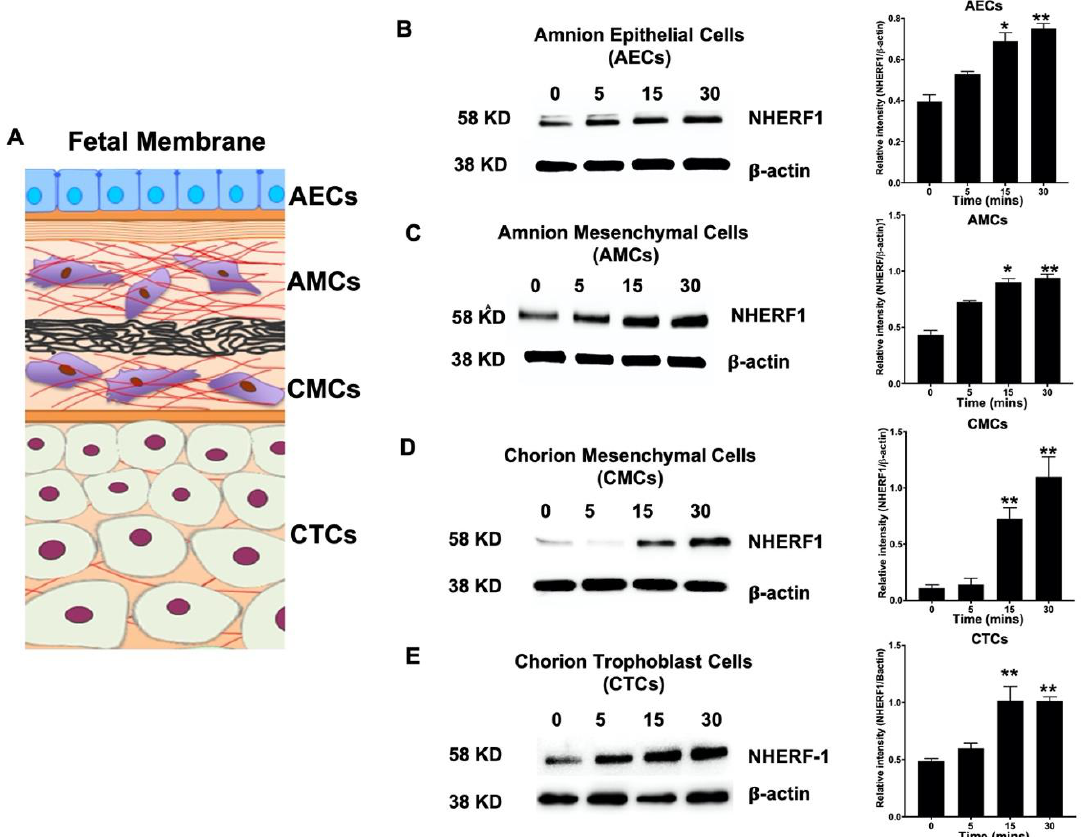
Figure 4. Expression levels of NHERF1 in human fetal membrane primary cells induced by LPS. ( A ) Representation of di ff erent layers of human fetal membrane. WB analysis of ( B ) amnion epithelial cells (AECs), ( C ) amnion mesenchymal cells (AMCs), ( D ) chorion mesenchymal cells (CMCs), and ( E ) chorion trophoblast cells (CTCs) to determine the levels of NHERF1 in response to LPS at di ff erent timepoints. The relative levels of NHERF1 significantly increased in a time-dependent manner with LPS treatment compared to the control in di ff erent layer cells of fetal membrane. The blots were stripped and reprobed with β -actin as a loading control. Bar graphs show relative intensities of bands for the NHERF1 protein for respective primary cells. Representative blots from n = 3 for each cell type are shown. Data presented as mean ± SEM. Statistical significance was determined by one way ANOVA. * p < 0.05, ** p ≤ 0.01 vs. 0